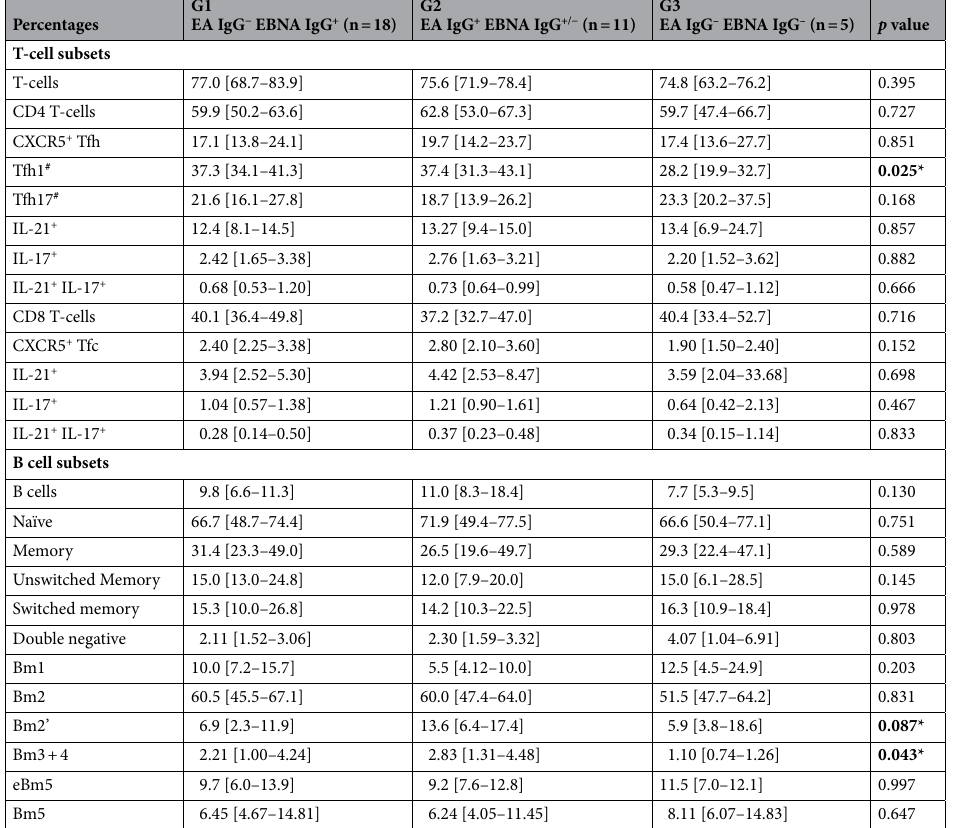
Table 4. Immune profile of SjS patients with distinct EBV serology patterns (percentages). Percentage values for all T and B cells subsets in median [minimum–maximum] in SjS patients evaluated for EBV serology. SjS Sjögren’s syndrome, EBV Epstein-Barr virus. # Tfh1 and Tfh17 are represented as percentages among CXCR5 + Tfh cells. * Bold numbers highlight the populations that were significantly different. Kruskal–Wallis test was applied for statistical